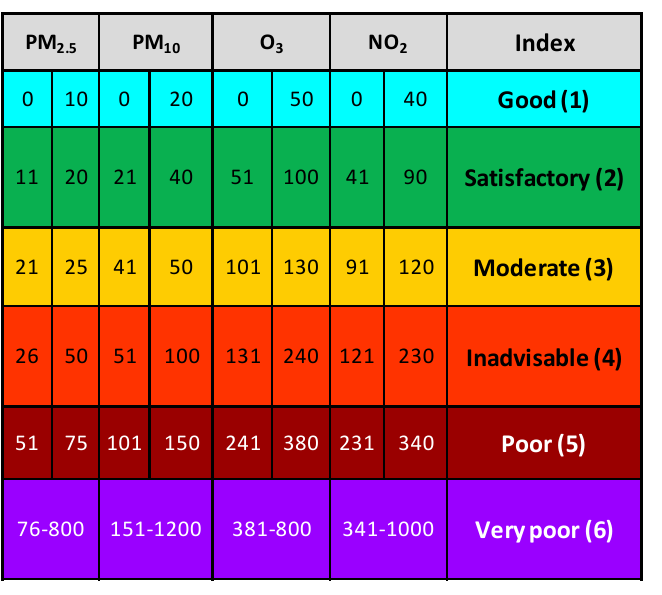
Figure 3. Air –quality levels ( μ g/m 3 ) established by Spanish legislation. Figure 3. Air–quality levels ( µ g/m 3 ) established by Spanish